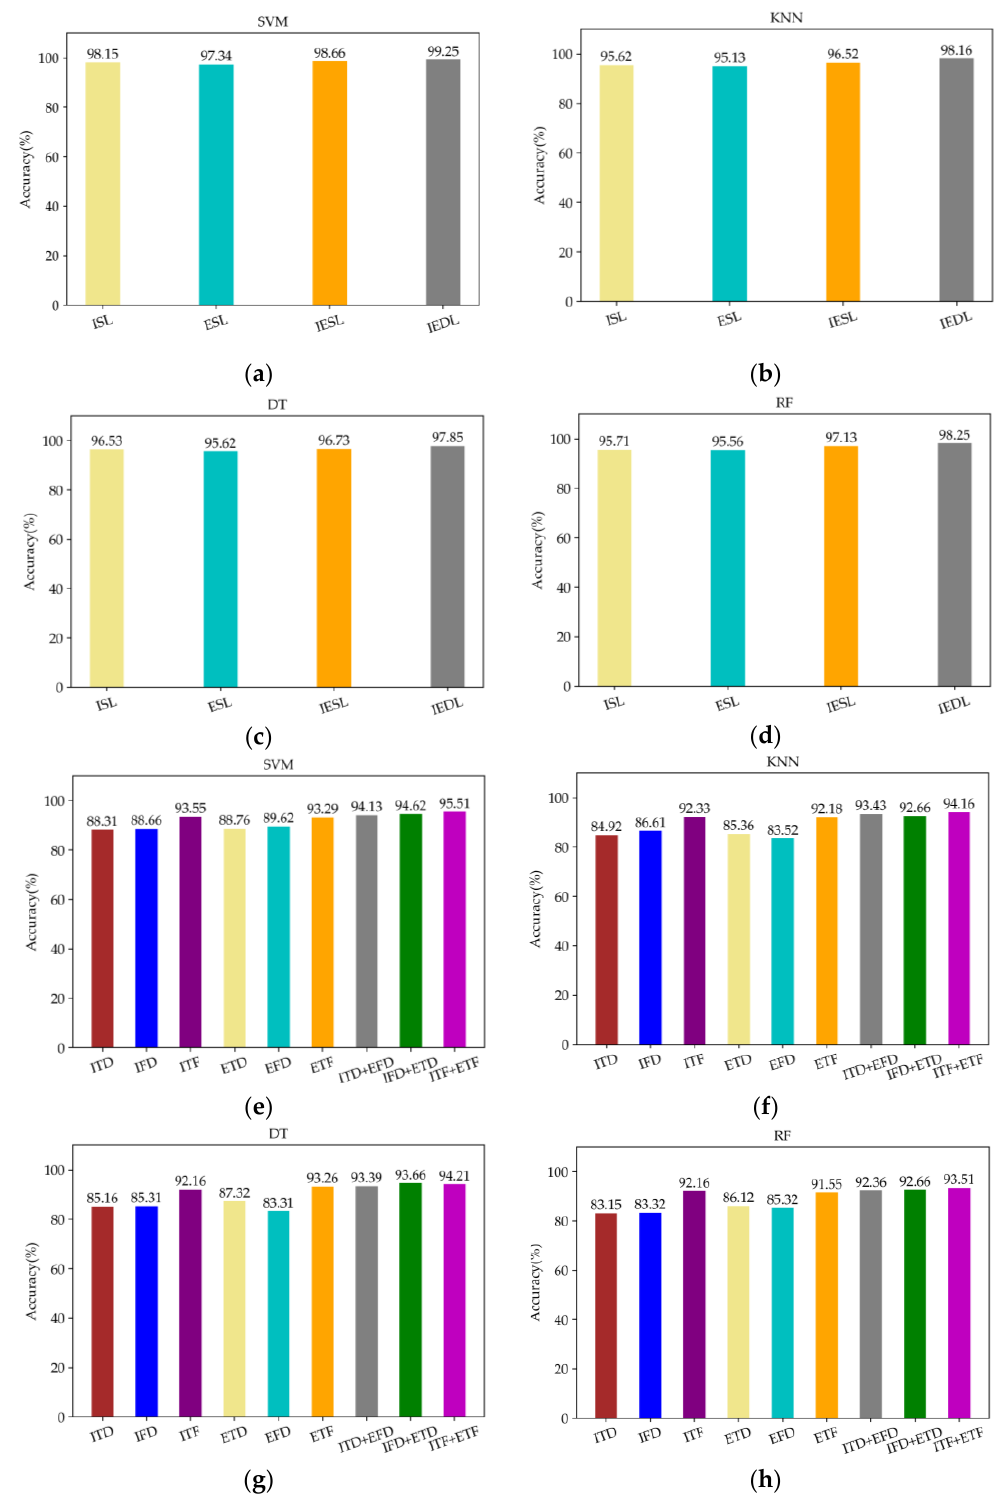
Figure 8. Recognition accuracy analysis of extracted features based on different methods and different types of sensor data. ( a – d ) represent the recognition accuracy of features extracted based on Dual Stream CNN-ReliefF and Single Stream CNN under SVM, KNN, DT and RF classifiers, respectively; ( e – h ) represent the recognition accuracy of features extracted based on manual design under SVM, KNN, DT and RF classifiers,